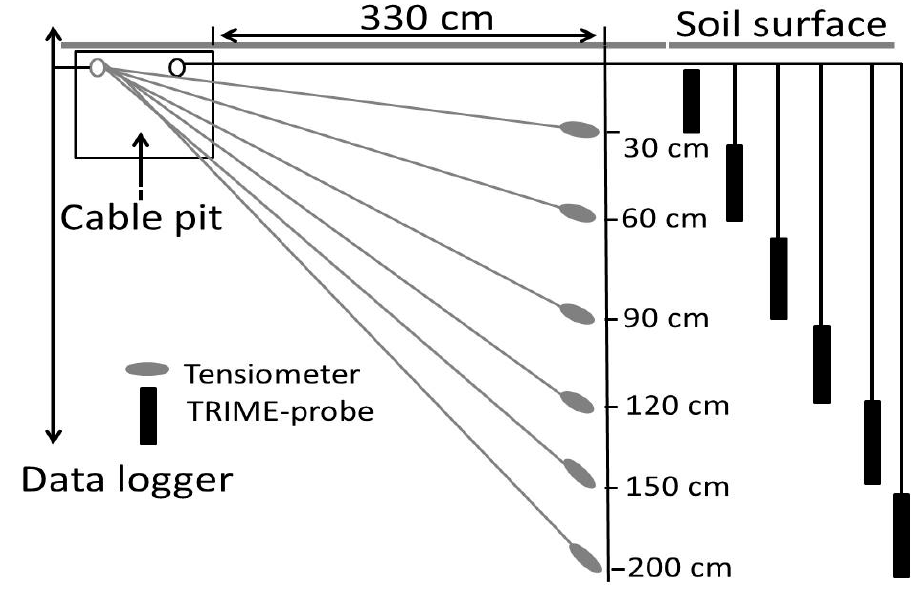
Figure 1. Installation of Time Domain Reflectometry with Intelligent MicroElements (TRIME) and tensiometer at the three field plots ([38], modified).